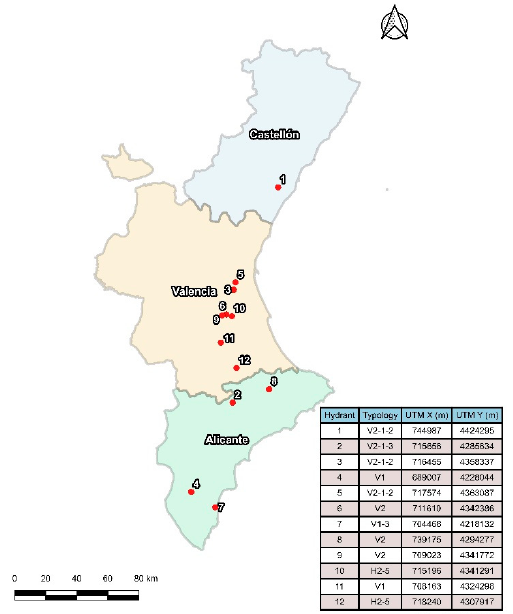
Figure 3. Locations of multioutlet hydrants identified in the field and tested in the laboratory. Data collection was carried out by running interviews with the WUAs’ managers.